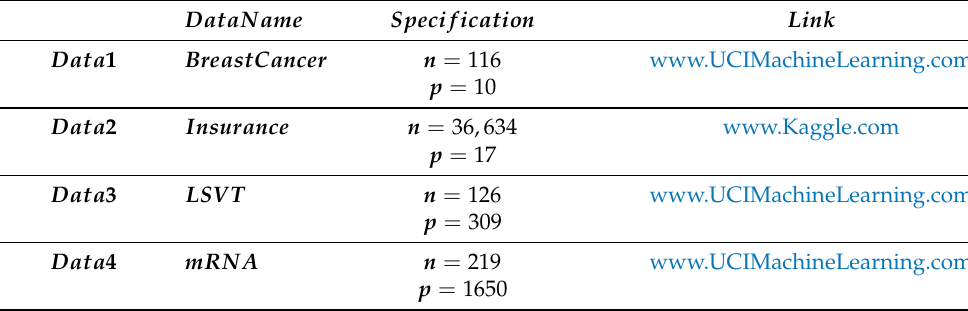
Table 4. Datasets (Accessed on 30 November